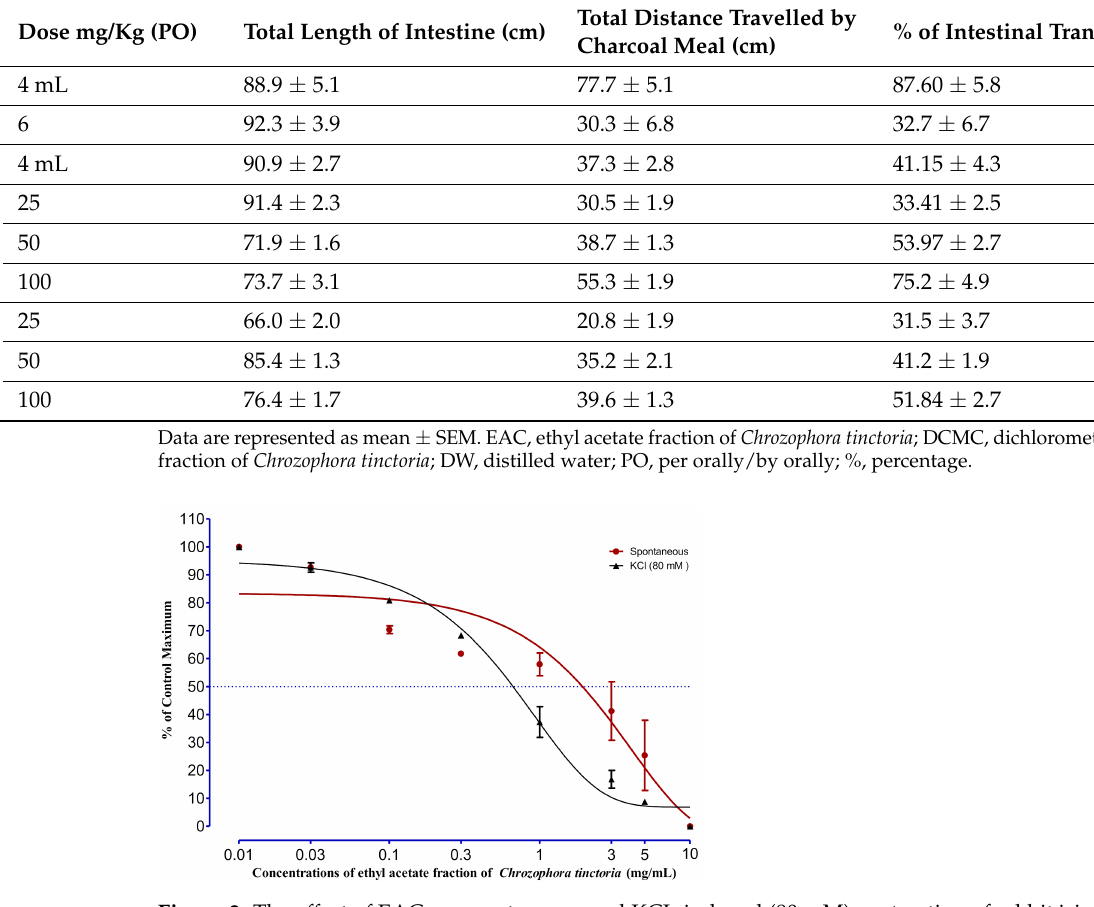
Figure 3. The effect of EAC on spontaneous and KCL-induced (80 mM) contraction of rabbit jejunum. Rabbit jejunum muscle was relaxed in a dose-dependent manner. EC 50 values were calculated from curve fitting in GraphPad prism 6.01. Each point represents the mean ± SEM of grouped data.